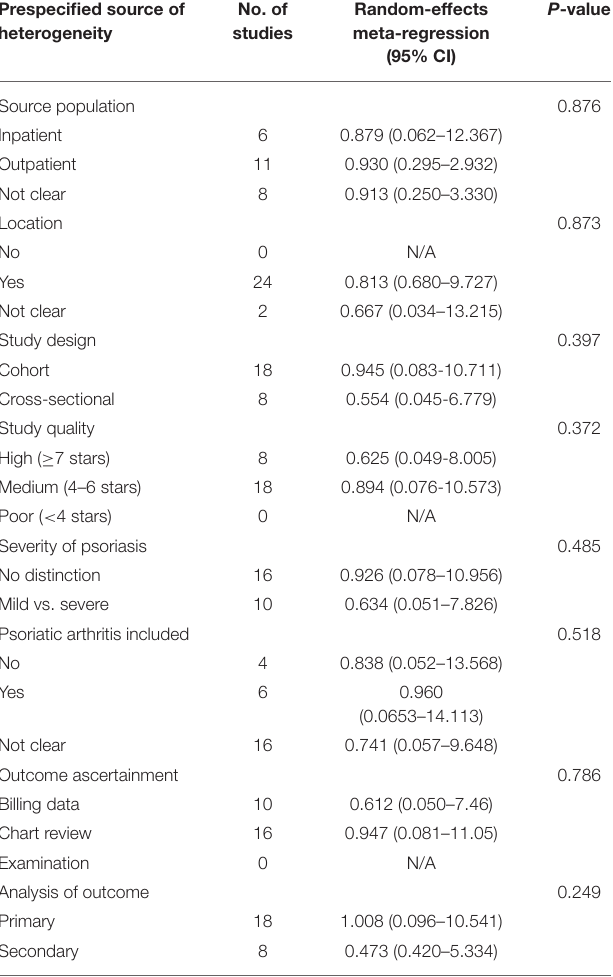
TABLE 3 | Potential prespecified sources of heterogeneity explored among studies reporting SUA levels of patients with psoriasis vs. controls. Prespecified source of